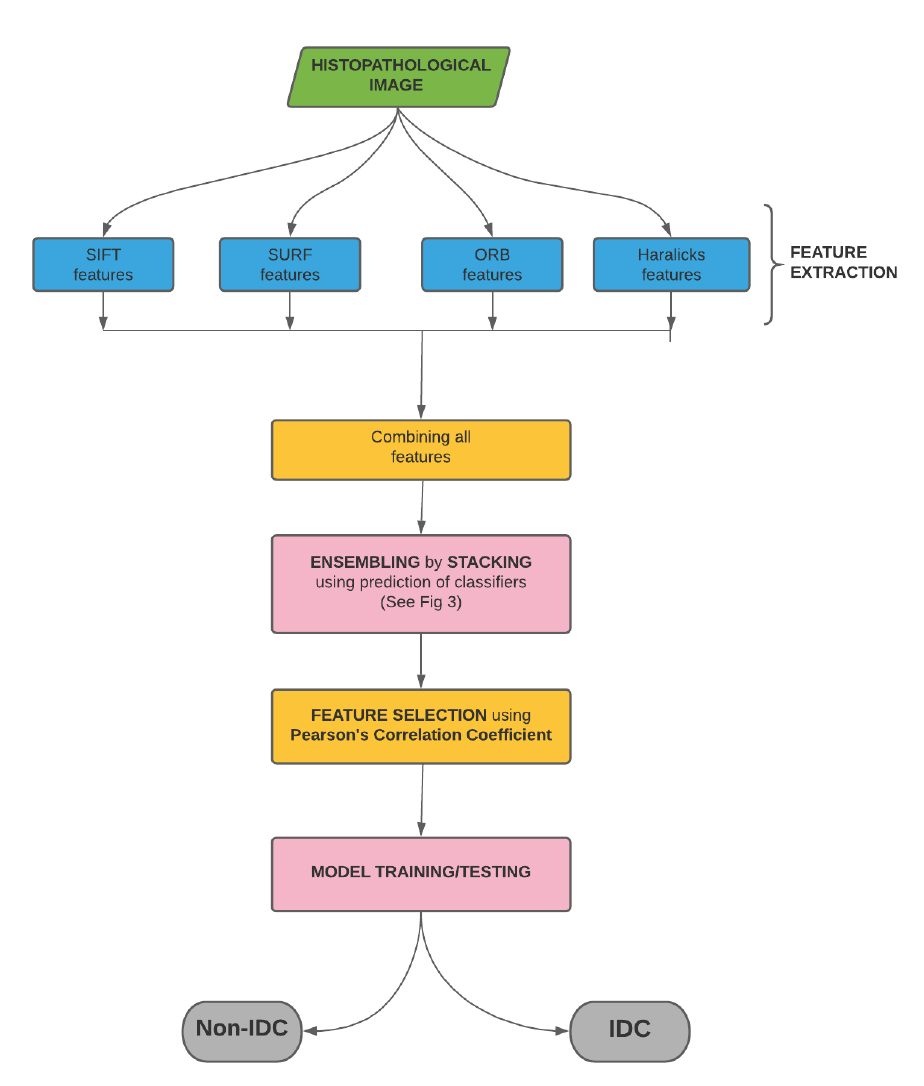
Figure 2. Pipeline of the proposed model used for breast cancer detection from histology images. We start with the histopathological image from which we extract 256 SIFT, 256 SURF, 256 ORB and 14 Haralicks features. The 782 (= 256 + 256 + 256 + 14) features are then combined. These features